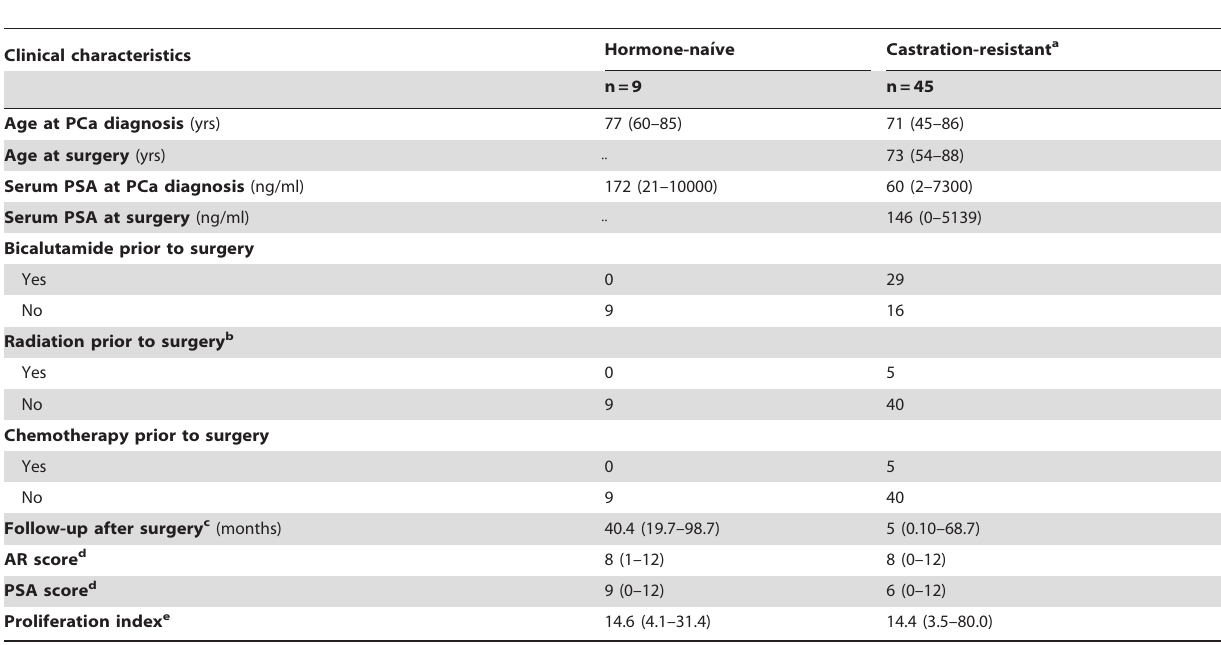
Table 1. Clinical and histological characteristics of prostate cancer patients with bone metastases and treated with metastasis